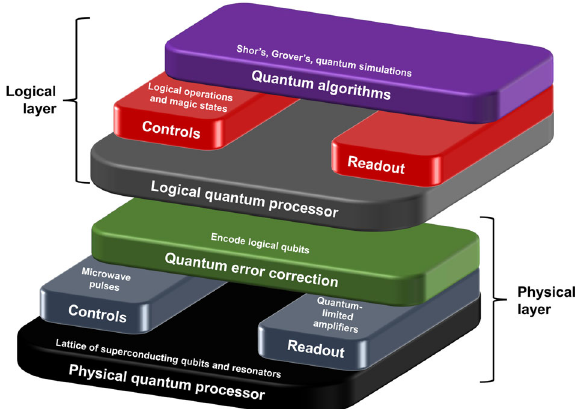
Fig. 1 A systems view of a quantum information processor. It consists of a physical and logical layer. The physical layer provides the error correction and consists of a physical quantum processor that has both input and output lines that are controlled by the QEC processor. This processor is in turn controlled by the logical layer, where the encoded qubits are de fi ned and the logical operations are performed for the desired quantum algorithm